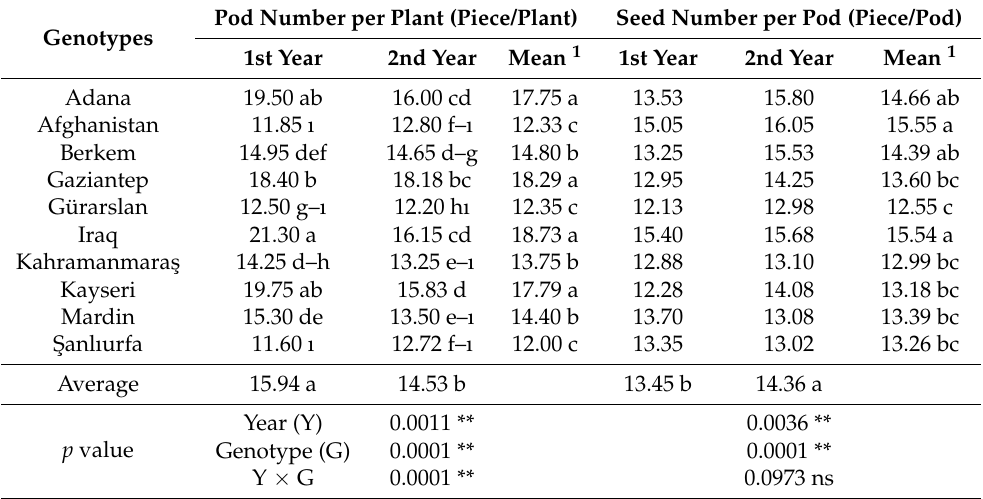
Table 5. Average values for the number of pods per plant and seeds per pod of fenugreek genotypes.